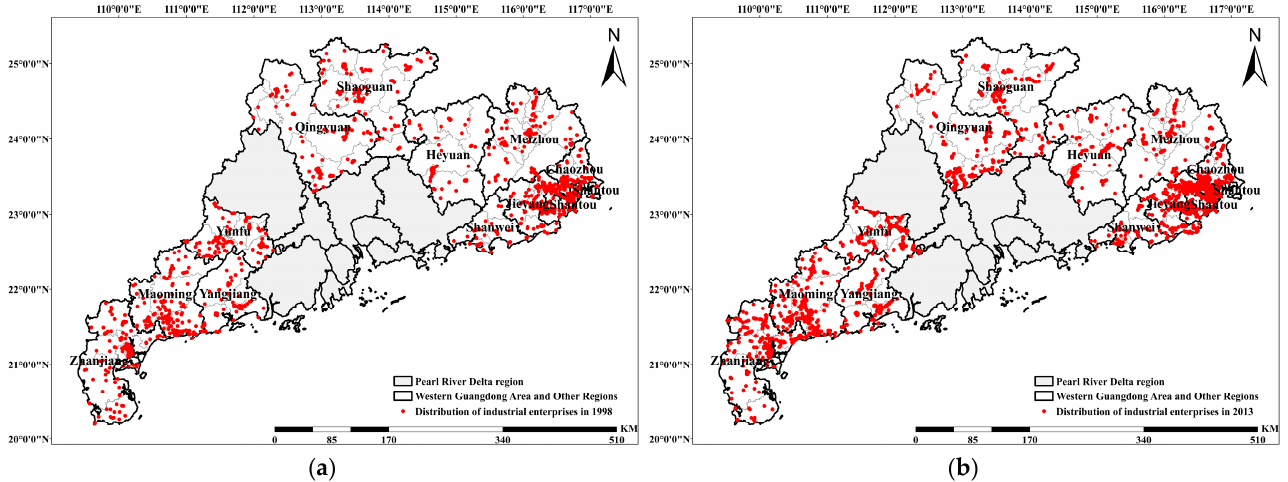
Figure 12. Change Chart of the Number of Enterprises in Some Industries in Northern, Eastern, and Western Guangdong. ( a )1998; ( b ) 2013.